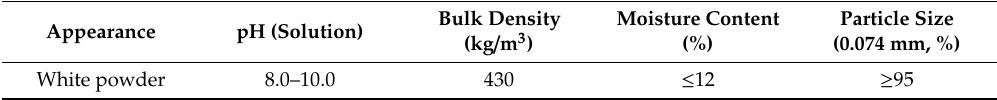
Table 7. Properties of viscosity modifying